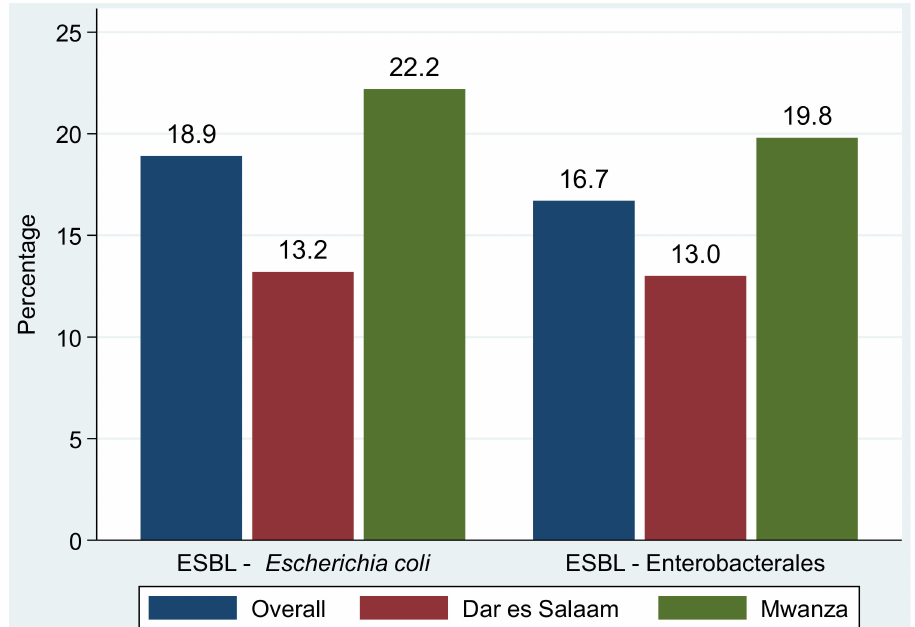
Figure 2. Proportions of extended-spectrum β -lactamase production in E. coli and other